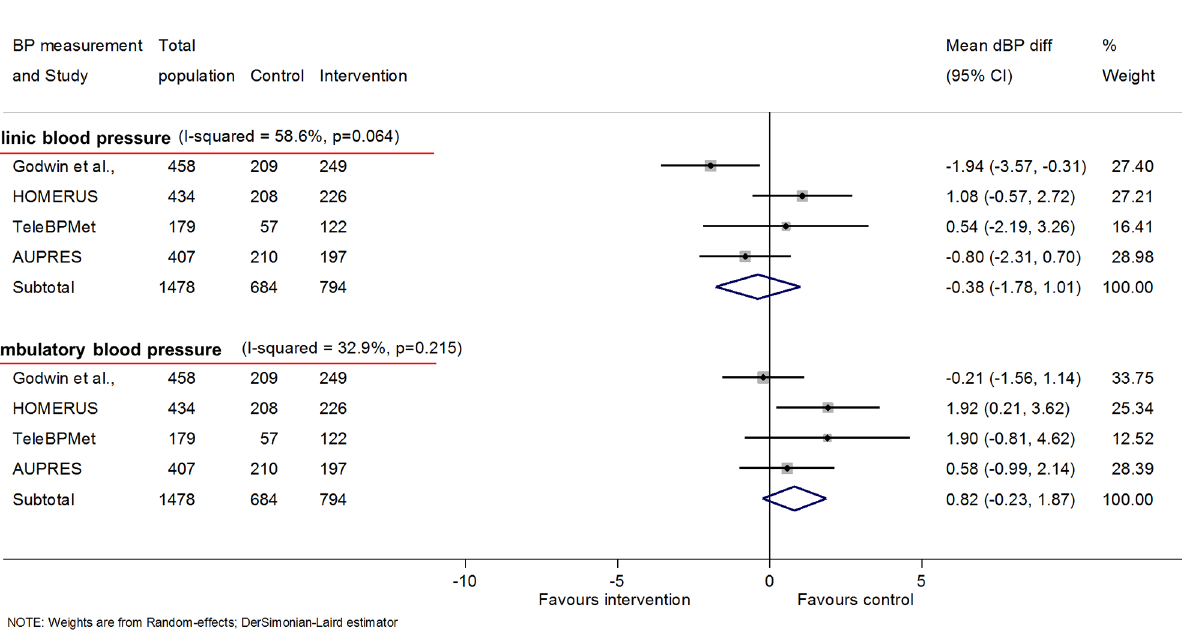
Fig 5. Impact of self-monitoring of BP on clinic and ambulatory dBP at 12 months (4 studies). These 4 studies used both clinic and ambulatoryBP as endpointsand so are presentedin addition to the overall results in Fig 1, which are for clinic BP alone (includingthese studies). Changein dBP adjustedfor age, sex, baselineclinic BP, history of diabetes, and level of intervention. Effect of self-monitoring on diastolic clinic and ambulatory BP at 6 months is in S10 Fig. Abbreviations: BP, bloodpressure; dBP, diastolicblood pressure.